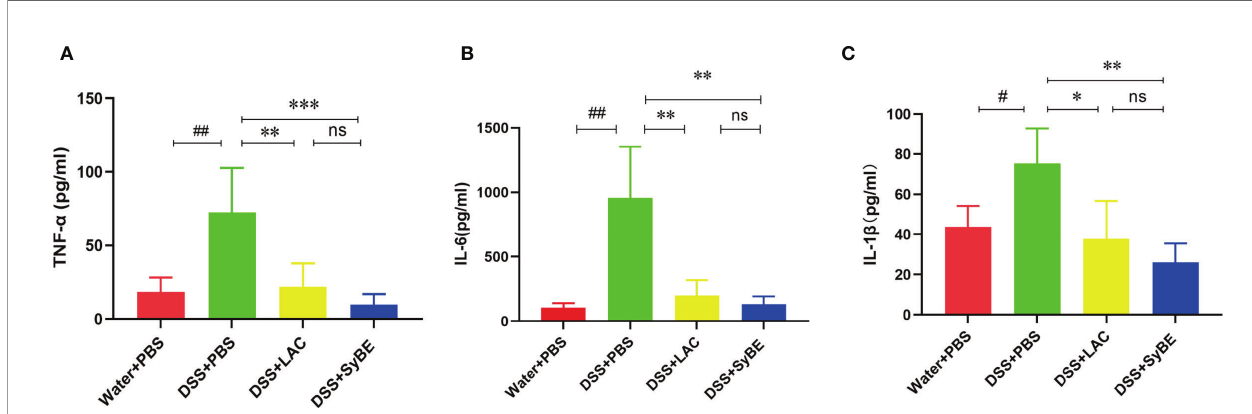
FIGURE 3 | Effect of lactic acid and lactic acid-producing Saccharomyces cerevisiae on in fl ammatory cytokines in the serum of mice. The serum was measured using the LEGENDplex ™ mouse in fl ammatory cytokine panel. (A – C) TNF- a , IL-6, and IL-1 b were measured. Statistical analysis was performed using unpaired t -test. Error bars represent standard errors. # p < 0.05; ## p < 0.01 vs. the Water+PBS group; * p < 0.05; ** p < 0.01; *** p < 0.001 vs. the DSS+PBS group. ns, no signi fi